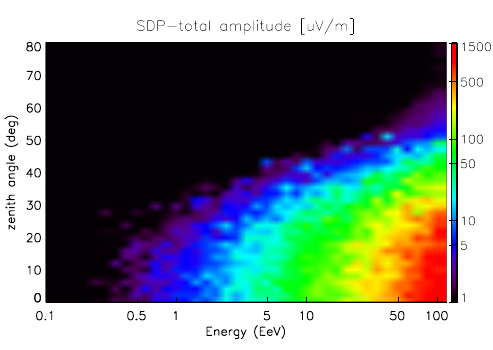
Figure 2. Two-dimensional colour plot of the total SDP maxi- mum amplitude as a function of the primary proton energy and shower zenith